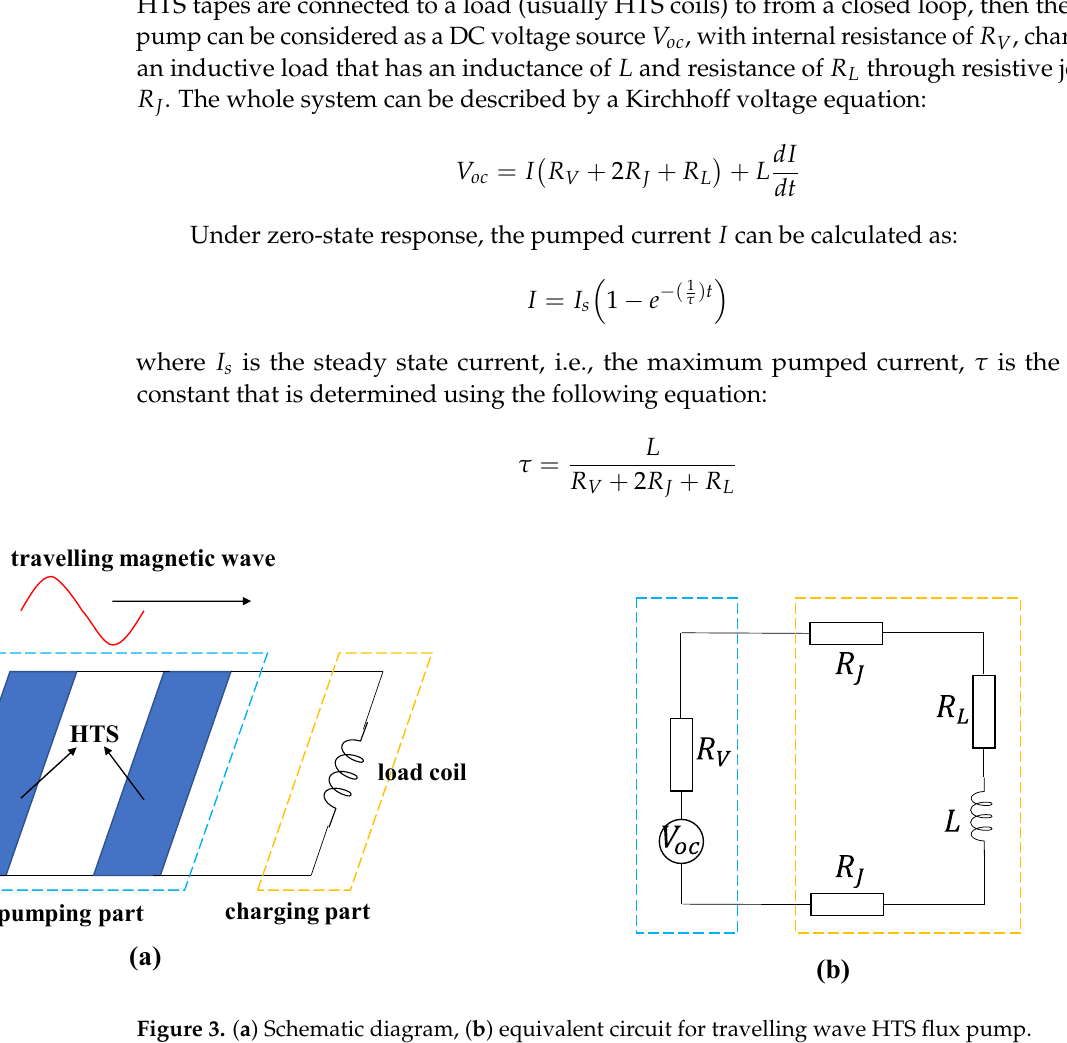
Figure 3. ( a ) Schematic diagram, ( b ) equivalent circuit for travelling wave HTS flux pump.